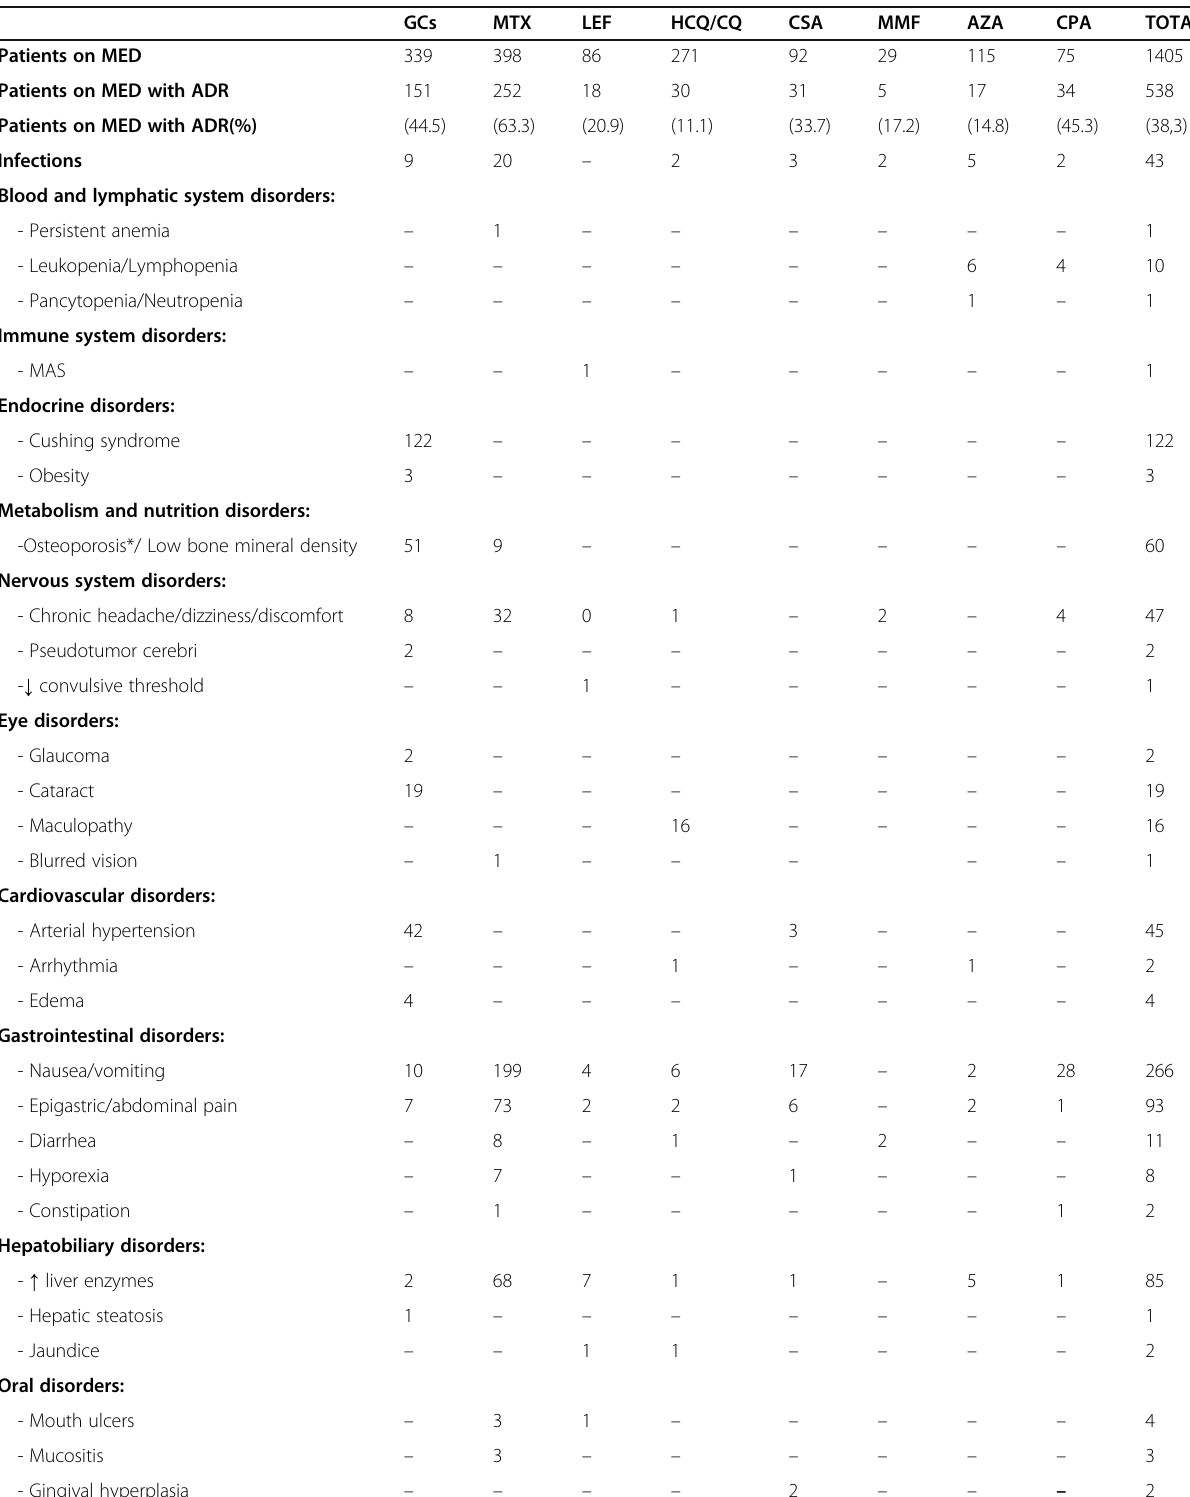
Table 1 ADRs of glucocorticoids and synthetic DMARDs in patients with JIA, JSLE and JDM